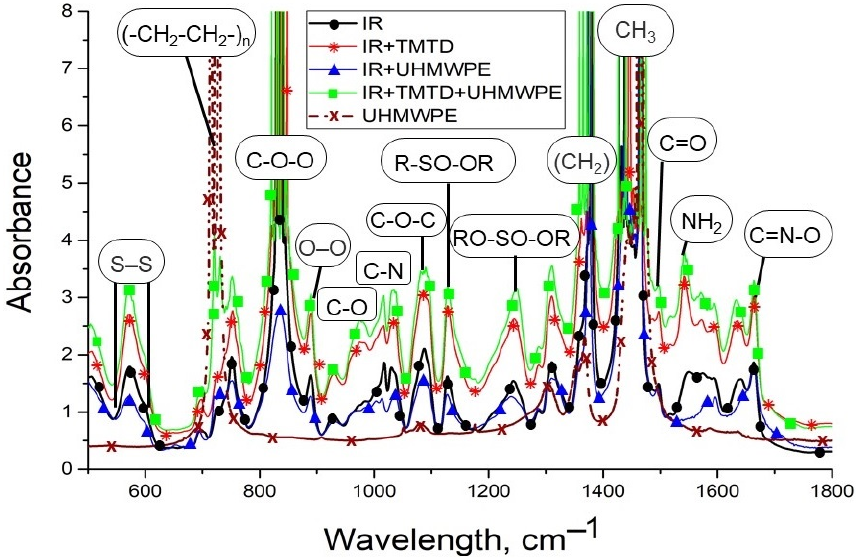
Figure 10. Comparison of IR spectra of initial polymer materials and UHMWPE mixture with elastomer.